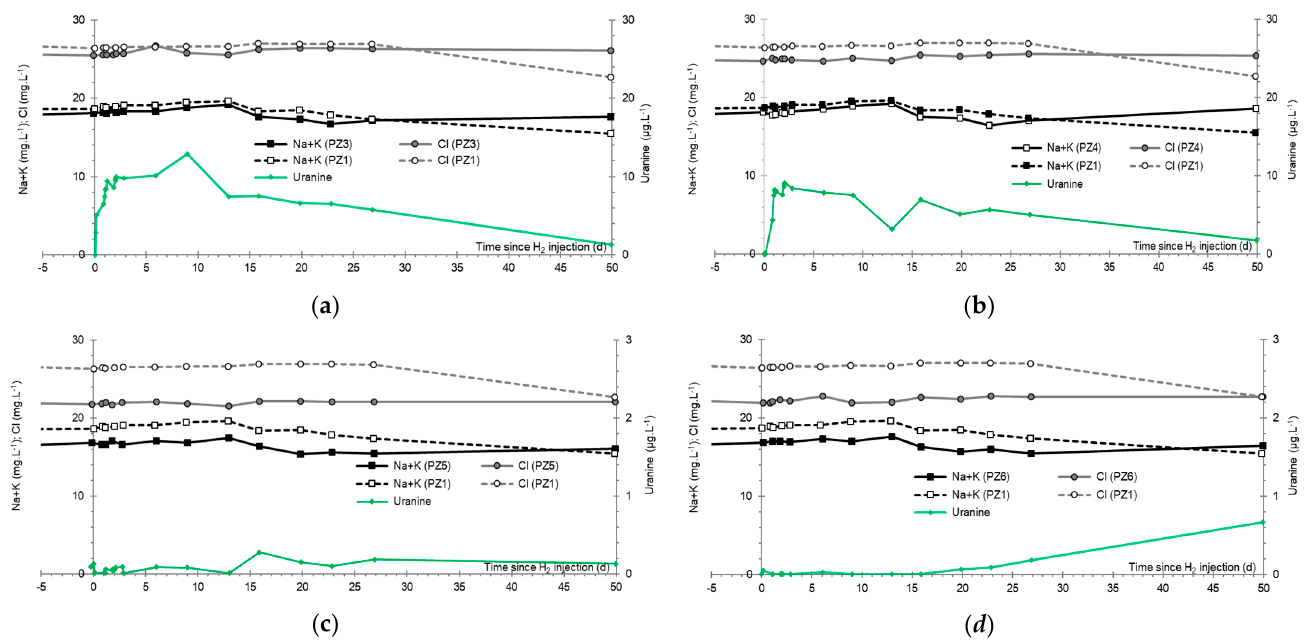
Figure 25. Comparative evolution of the concentrations of chlor-alkali ions and tracer at PZ1 (20 m upstream) and at the downstream piezometers: ( a ) PZ3(10 m); ( b ) PZ4 (20 m); ( c ) PZ5 (30 m); and ( d ) PZ6 (70 m).